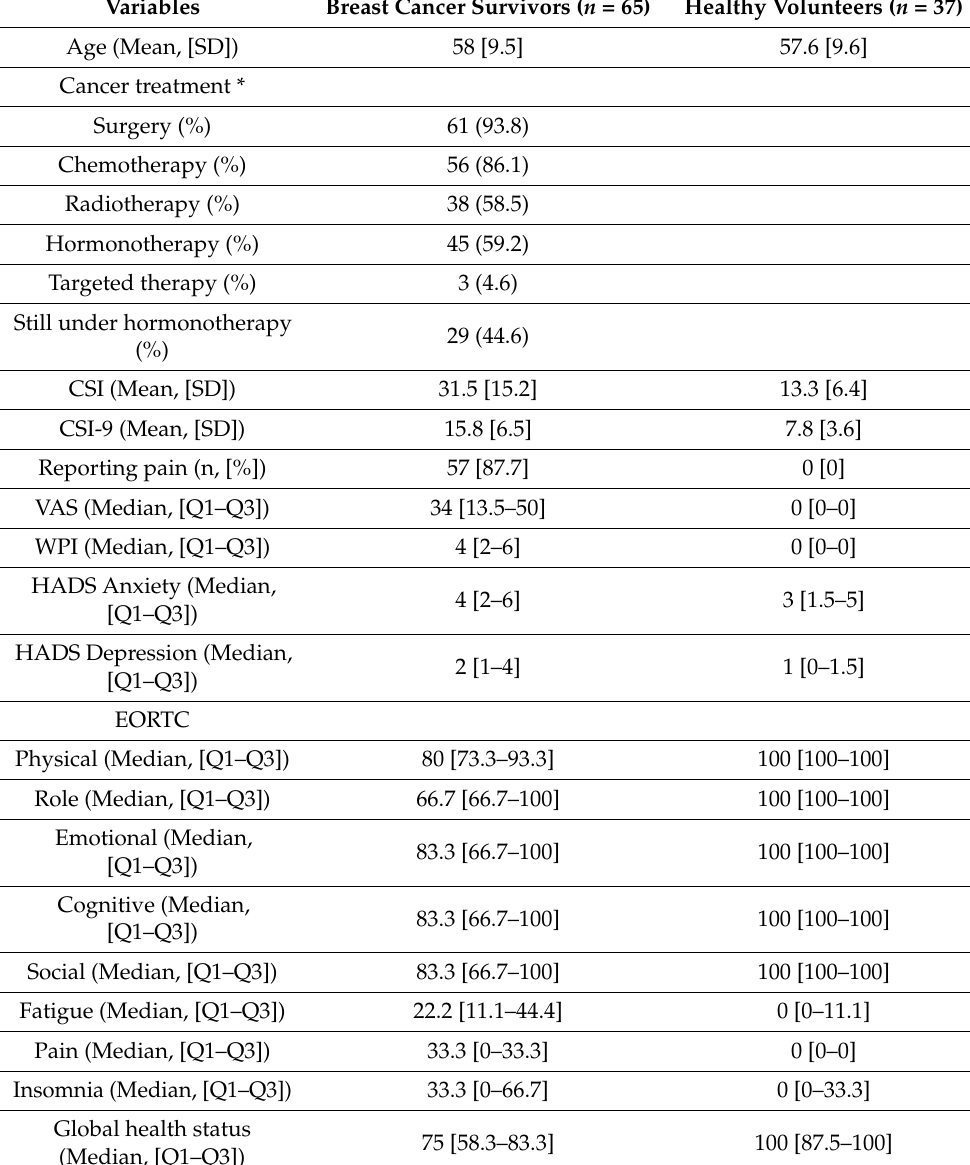
Table 1. Participant characteristics ( n =